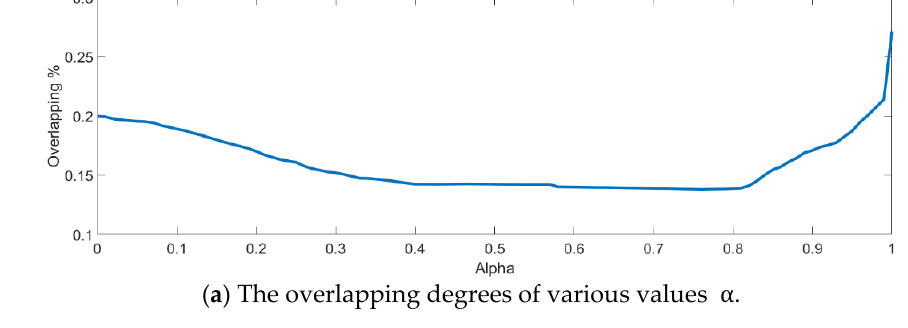
( a ) The overlapping degrees of various values α .